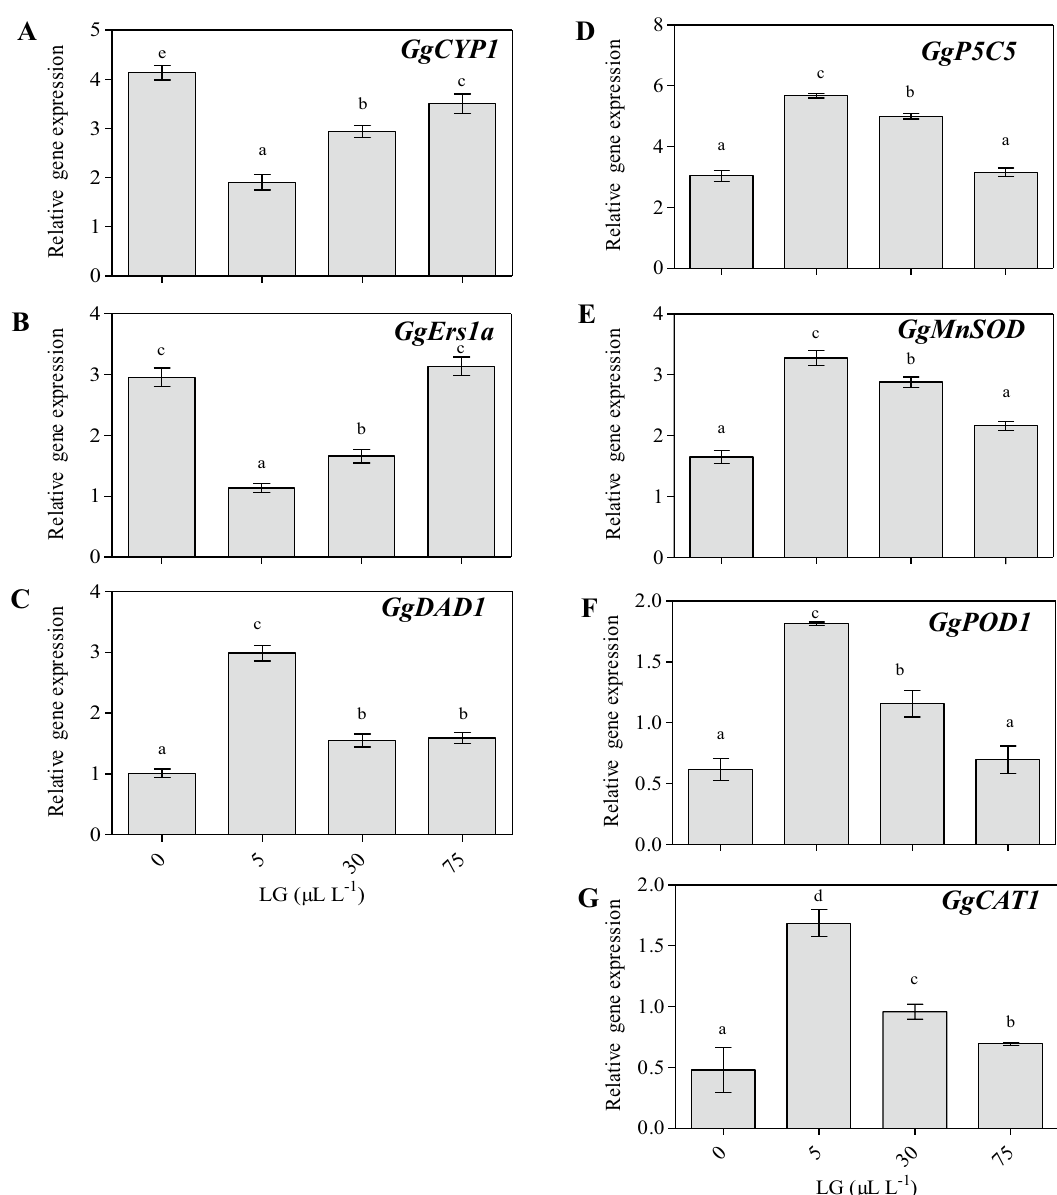
Figure 6. The transcripts levels of senescence associated genes GgCYP1 ( A ) , GgErs1a ( B ), GgDAD1 ( C ) and antioxidants encoding genes GgP5C5 ( D ), GgMnSOD ( E ), GgPOD1 ( F ) GgCAT1 ( G ) in the petals of untreated (distilled water) and LG oil treated spikes ((5, 30 and 75 µL L −1 ) of Gladiolus grandiflorus . Each value is the mean ± SE of three replicates. Means with different letters are significantly different at 5% probability (Tukey’s